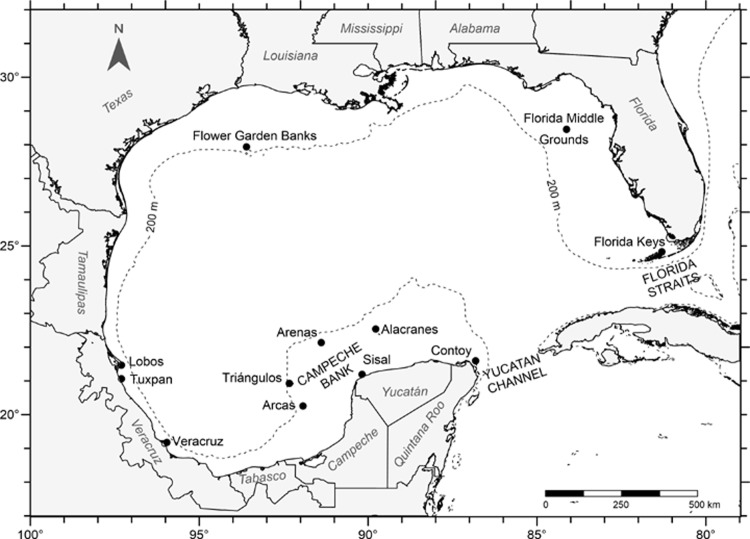
Geographical location of the twelve coral reef systems within the Gulf of Mexico.